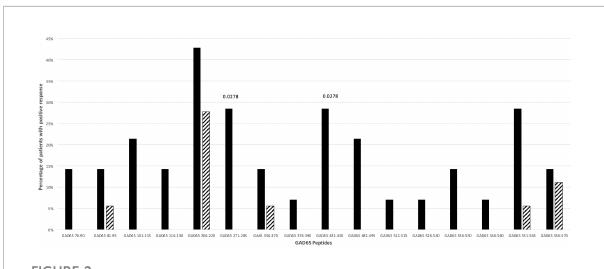
FIGURE 2 Percentage of T1D patients (solid bars) and controls (hatched bars) responding to GAD65 peptides. Signi fi cant p values (<0.05) are indicated above the corresponding bars. Statistical analysis was performed using the Fisher ’ s exact test.